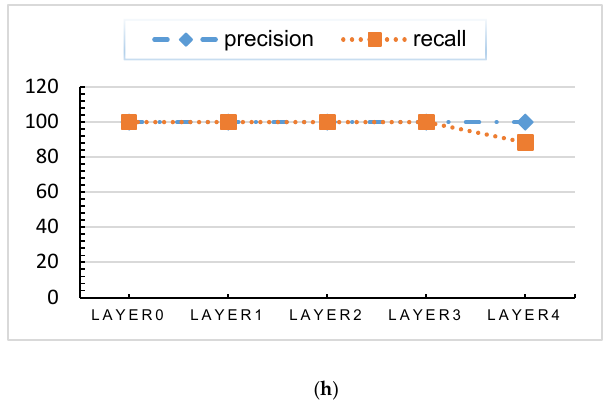
Figure 6. Precision and recall of the clustering results: ( a ) normal, ( b ) NMRI, ( c ) CMRI, ( d ) MSCI, ( e ) MPCI, ( f ) MFCI, ( g ) DoS, and ( h ) reconnaissance data.